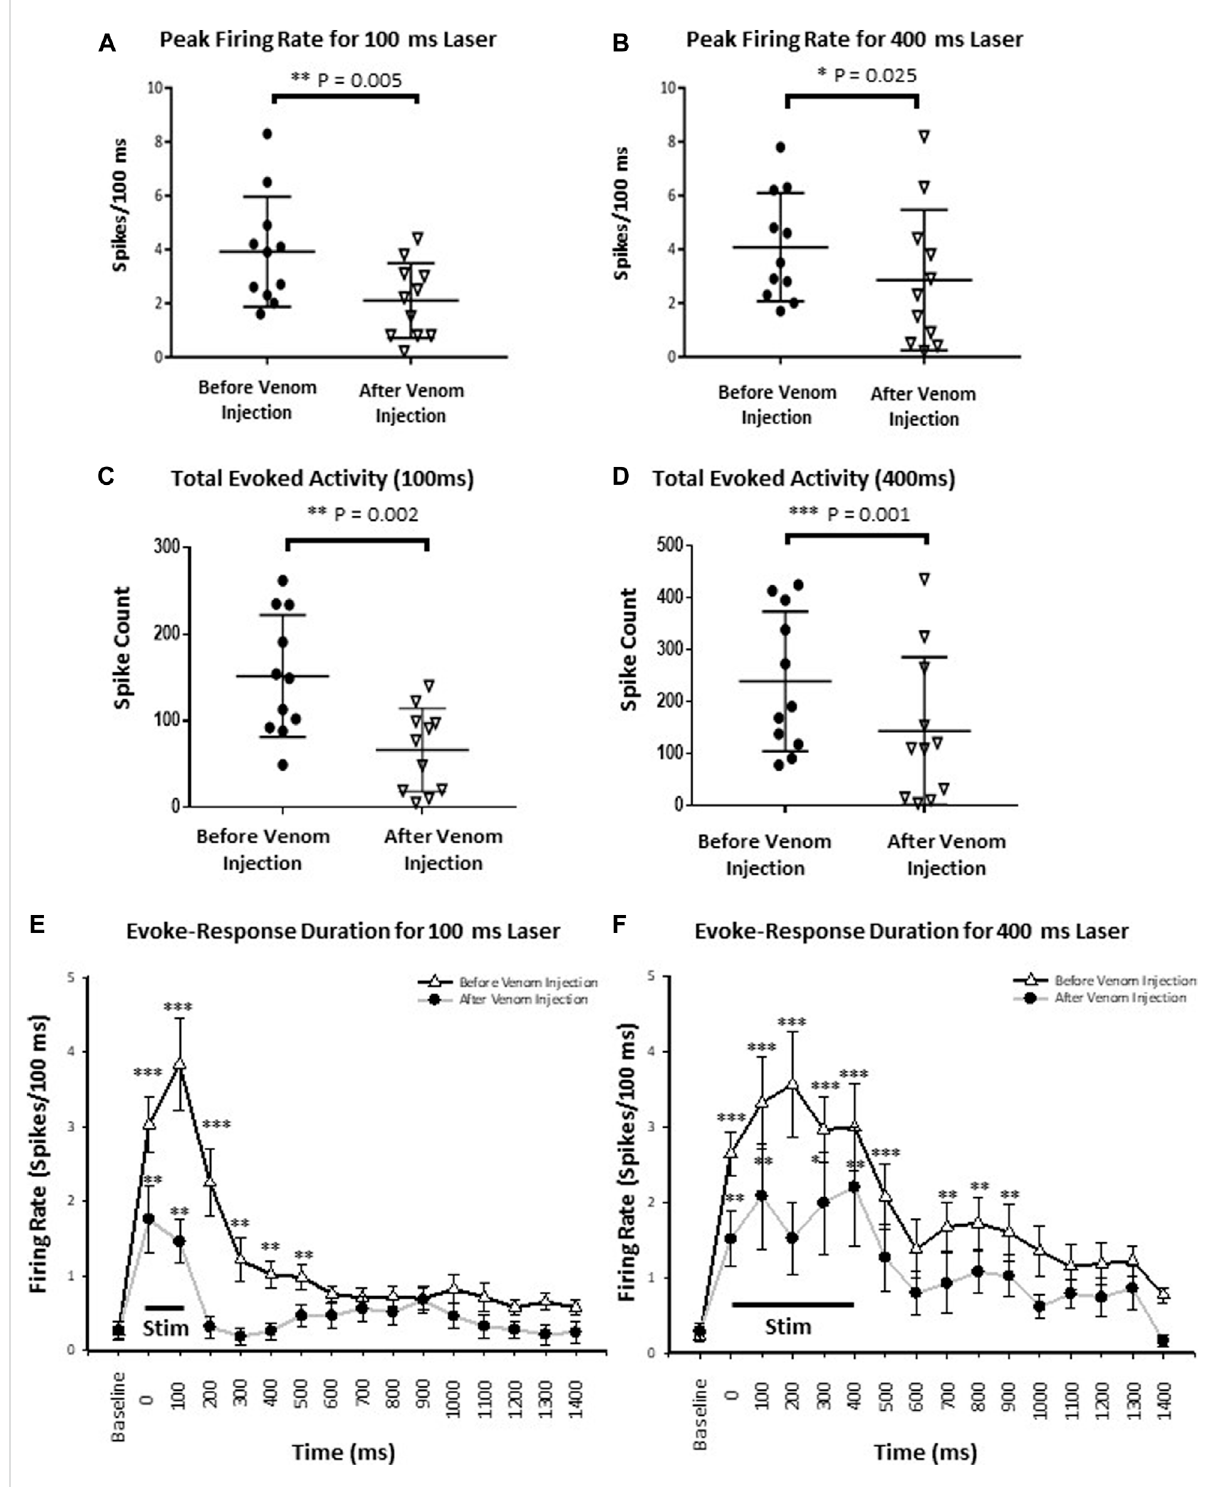
FIGURE 7 WaspvenomreducestheCXactivityinresponsetonociceptivestimuli. (A) Peak fi ringratedecreasesaftervenominjectionforineffectivestimuli (100 ms laser stimuli). (B) Same as panel (A) for effective stimuli (400 ms laser stimuli). (C) Total Evoked activity decreases after venom injection for ineffective stimuli (100 ms laser). (D) Same as panel (C) for effective stimuli (400 ms laser stimuli). Black circles represents data point before the venom injection for ineffective and effective stimulus, downward triangles represents data point after venom injection. (E) Peri-stimulus time histograms for ineffective 100 ms laser stimulus before (black line with white triangle) and after venom injection (grey line with black dot). The black line at the bottom represents the duration of stimulus. The mean response and duration of response decreases after venom injection for each stimulustype. (F) Sameaspanel (E) foreffectivestimulus.Forallpanels,pointsrepresentmeans±SEM,signi fi canceisindicatedwithanasterisk(*: p ≤ 0.05; **: p ≤ 0.01; ***: p ≤ 0.001, n = 11 units from 7